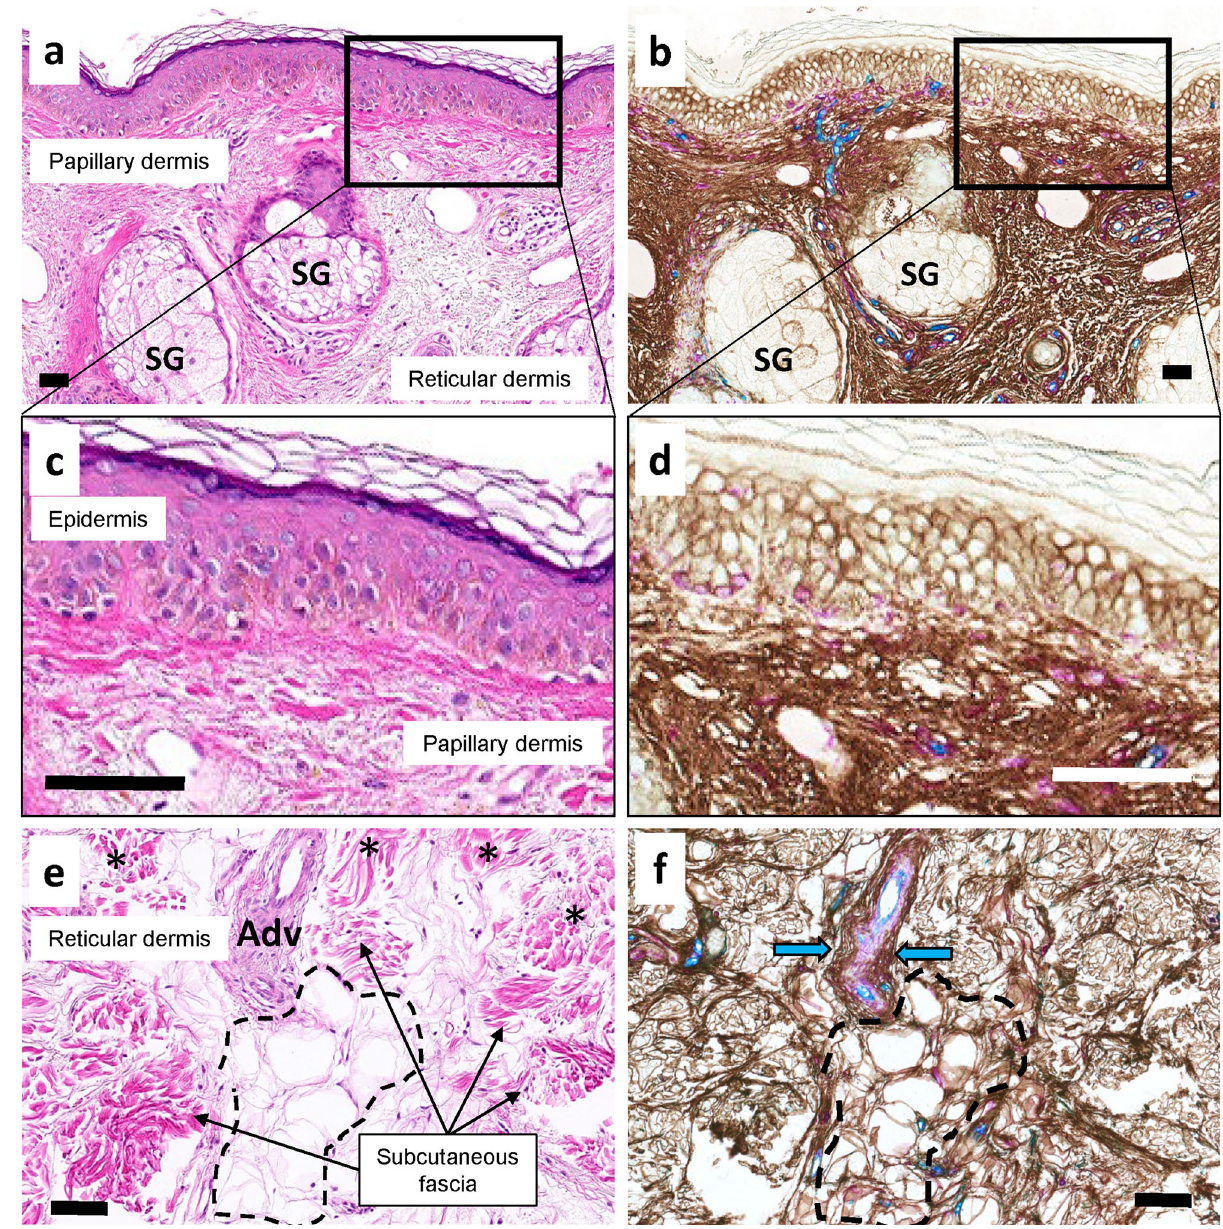
Fig. 5 Continuity of interstitial spaces through all layers of the skin into the subcutaneous fascia. Adjacent colon samples were stained with H&E (left) and a triplex chromogenic assay (right) for HABP (brown), vimentin (magenta), and CD34 (teal). a , b Junctional region between the papillary dermis and reticular dermis with adnexal sebaceous glands (SG). HABP staining of HA shows continuity from epidermal interstitial spaces through to the reticular dermis. (×10 magni fi cation). c , d Rectangular regions from the top images expanded showing continuity from epidermal intercellular spaces into the papillary dermis (×60 magni fi cation). e , f The lower reaches of papillary dermis (*) extending into the subcutaneous soft tissues with perivascular adventitia (Adv) and subcutaneous fascia separated by adipose tissue. HABP staining highlights the continuity between all these spaces including intercellular spaces and pericapillary spaces between adipocytes (dashed line) and the larger spaces of the reticular dermis, subcutaneous fascia, and perivascular adventitia (blue arrows). Scale bars = 100 μ